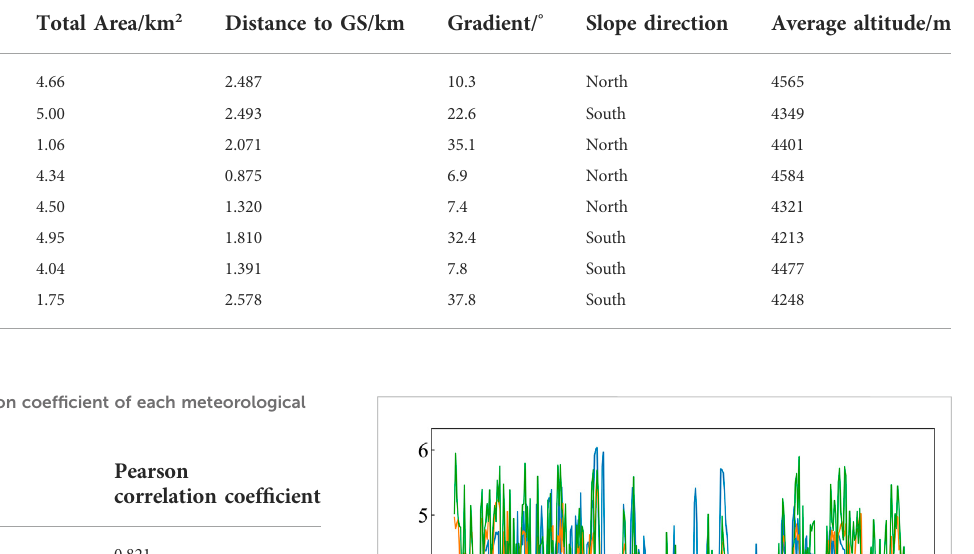
TABLE 1 The geographic conditions of each terrain.